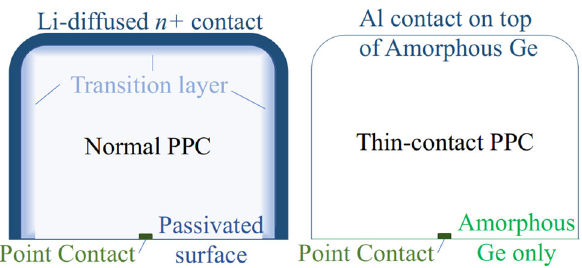
Fig. 1 Comparison between a normal and a thin-contact PPC HPGe detector (not to